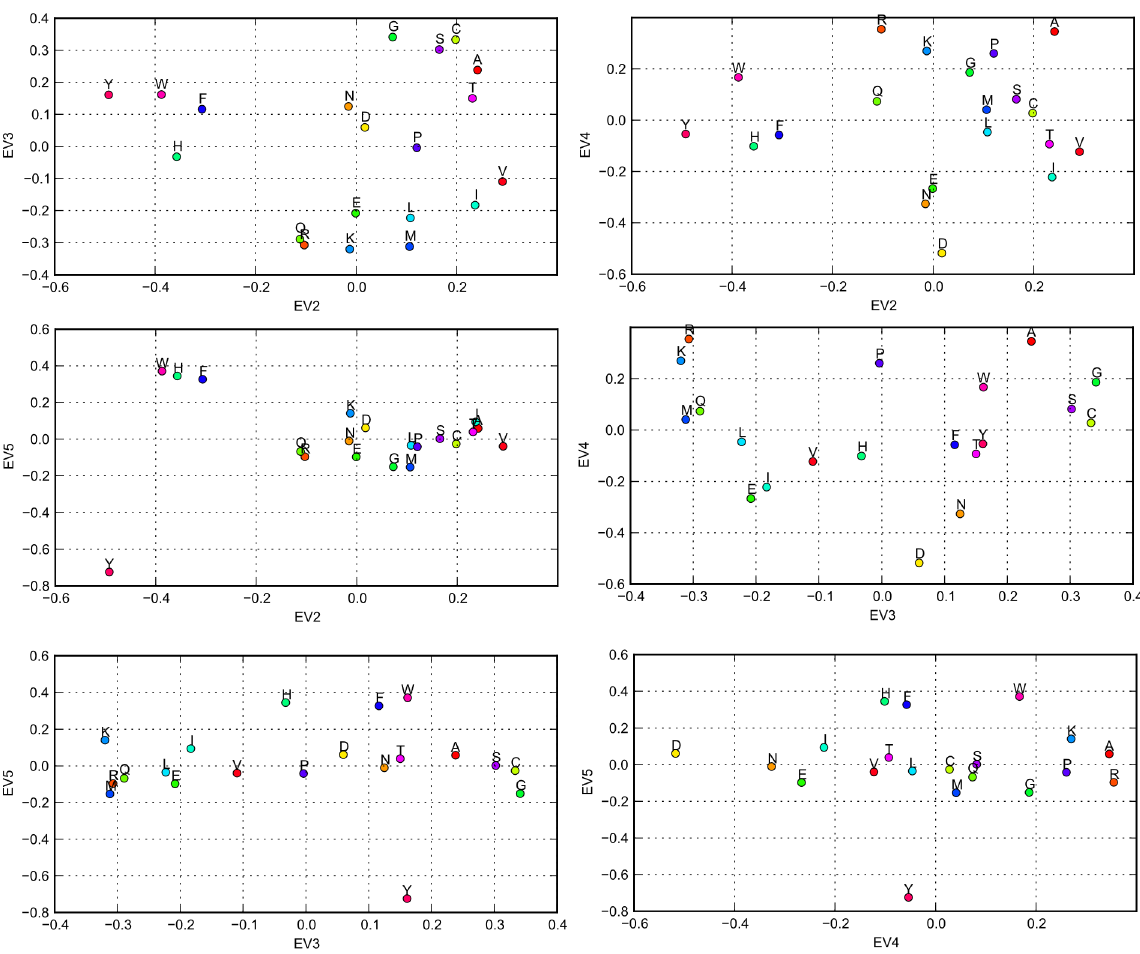
Figure 6. Amino acids in the eigenvector space. Six panels display projections of amino acids on all combinations space spanned on four eigenvectors: EV2, EV3, EV4 and EV5.